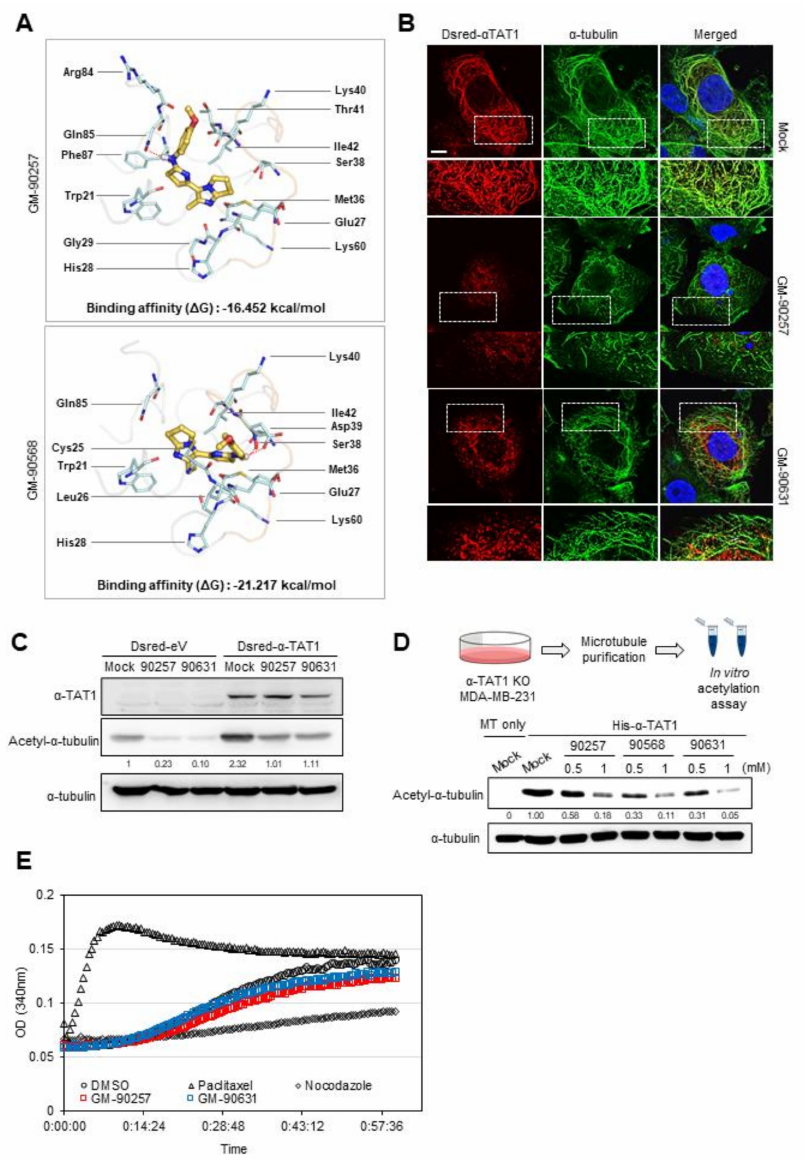
Figure3. Predictionofthedisruptionoftheinteractionbetweenmicrotubulesand α TAT1bymicrotubule acetylation inhibitors. ( A ) Predicted molecular docking models between acetylation inhibitors and the K40residuein α -tubulin. Chemical-proteininteractionsandresiduesintheimageswerevisualizedusing PyMOLprogram, andthebindinga ffi nitywasobtainedfromGalaxyWEB.Hydrogenbondsareindicated by dashed red lines, and pale cyan sticks represent residues interacting with chemical compounds in α -tubulin. ( B ) Overexpressed α TAT1 (red), α -tubulin (green), and nucleus (blue) in MDA-MB-231 cells were detected by immunofluorescence staining. Scale bar, 50 µ m. ( C ) DsRed- α TAT1-expressed MDA-MB-231 cell lysates were analyzed by western blotting. ( D ) Microtubules purified from α TAT1 KO MDA-MB-231 cells were incubated with His- α TAT1, acetyl-CoA, and one of the inhibitors (GM-90257, GM-90568, and GM-90631; 0.5 and 1 mM) or DMSO as a control for 30 min at 37 ◦ C. ( E ) In vitro microtubule polymerization assay. DMSO was used as a vehicle control, and all reagents including paclitaxel, nocodazole, GM-90257, and GM-90631 were used at the same concentration of 1 µ